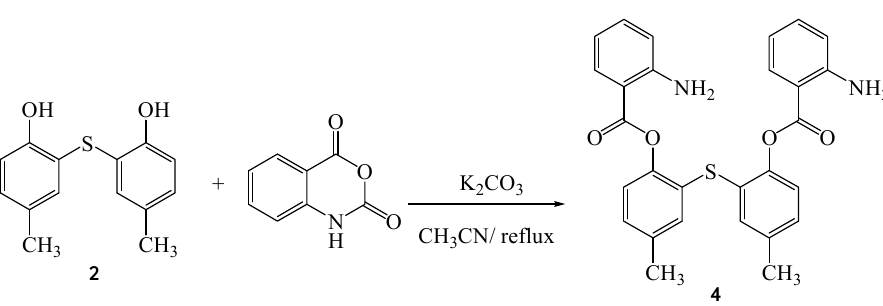
Scheme 1. Synthetic route to the title compound 4